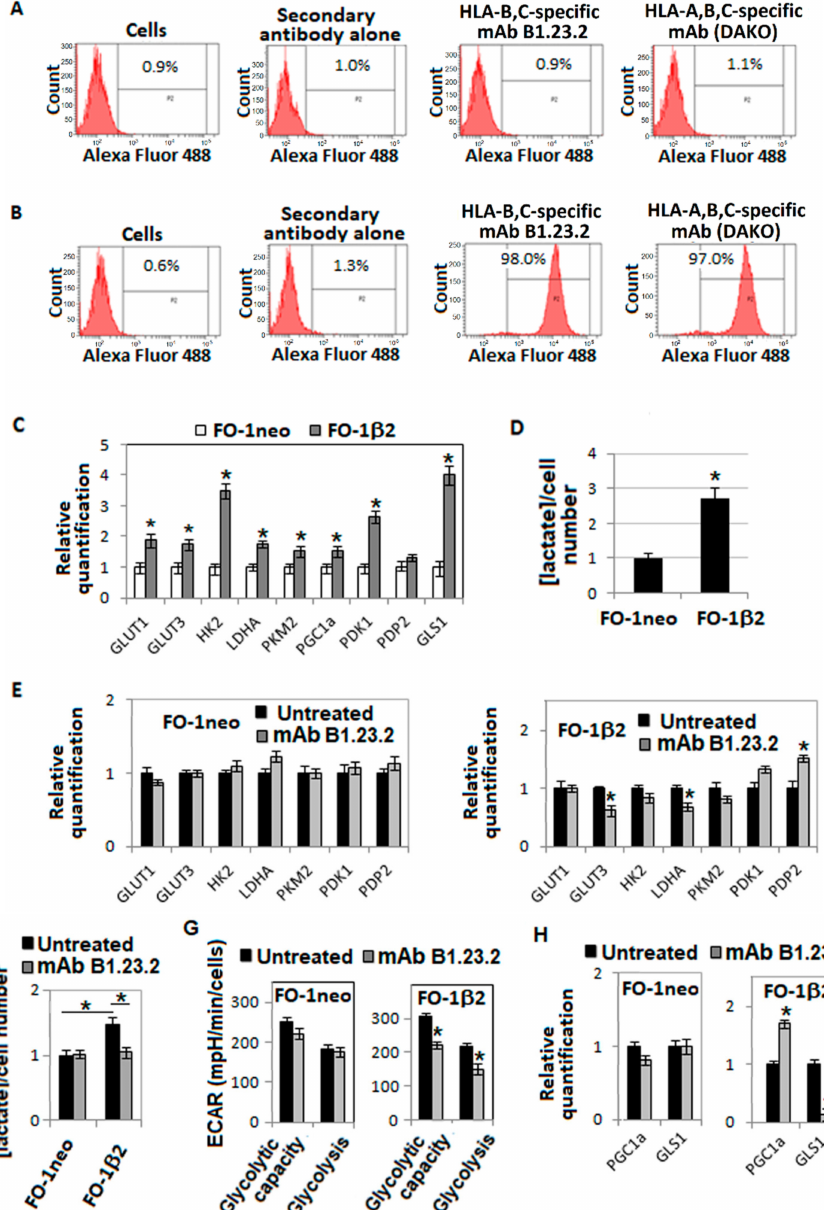
Figure 3. E ff ect of the HLA-B,C-specific mAb B1.23.2 on the metabolism of FO-1neo / FO-1 β 2 model of melanoma cells. FO-1neo ( A ) and FO-1 β 2 ( B ) melanoma cells were stained with the HLA-B,C-specific mAb B1.23.2 and analyzed with a flow cytometer. Representative plots are shown in the panels. Evaluation by quantitative real-time PCR of genes involved in metabolism in FO-1neo or FO-1 β 2 cells ( C ). Lactate released by FO-1neo or FO-1 β 2 melanoma cells corrected for number of cells ( D ). Evaluation by quantitative real-time PCR of genes involved in glycolytic metabolism ( E ) or in oxidative metabolism ( H ) in FO-1neo or FO-1 β 2 cells treated with the HLA-B,C-specific mAb B1.23.2 for 24 h at 37 ◦ C. Lactate released by FO-1neo or FO-1 β 2 melanoma cells treated with the HLA-B,C-specific mAb B1.23.2 for 24 h at 37 ◦ C corrected for number of cells ( F ). Glycolysis and glycolytic capacity extracted from glycolysis stress assay results obtained using the Seahorse Analyzer of FO-1neo and FO-1 β 2 melanoma cells treated with the HLA-B,C-specific mAb B1.23.2 (10 µ g / mL) for 24 h at 37 ◦ C ( G ). Values presented are the mean ± SEM of the results obtained in three independent experiments. * p <